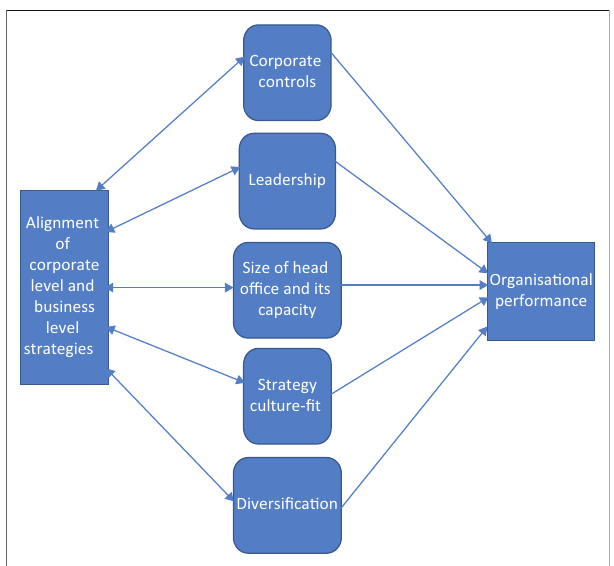
FIGURE 1: Conceptual framework underpinning this study.